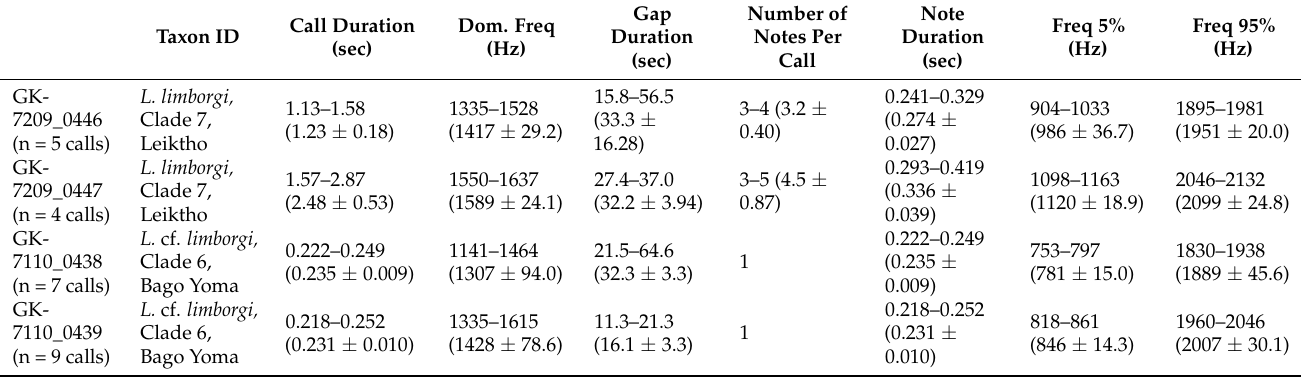
Table 5. Selected bioacoustic parameters of the species related to Limnonectes limborgi. Range is followed by mean value and standard deviation in parentheses. Dom. Freq. = dominant frequency; Freg. = frequency.